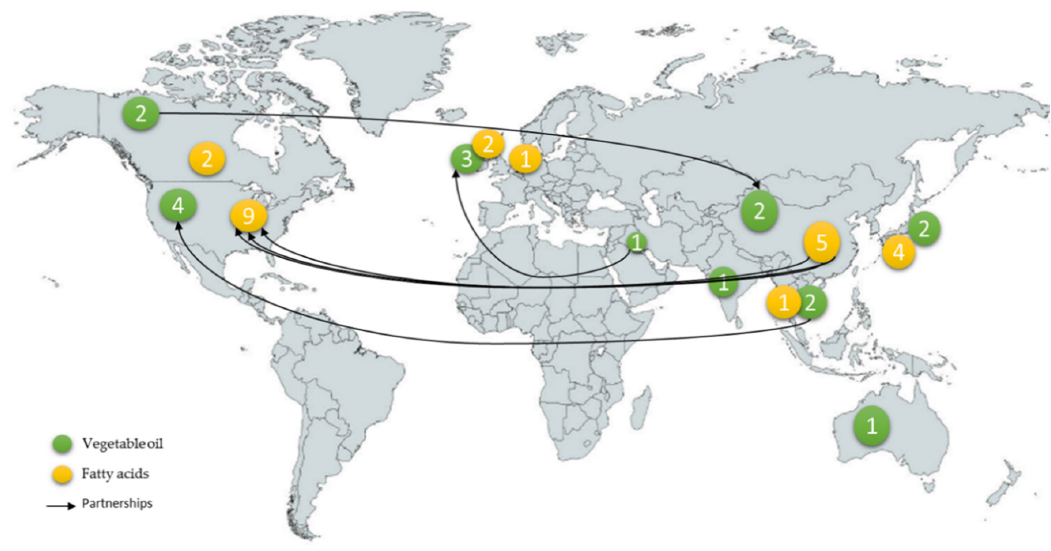
Figure 6. Number of articles published per each country.